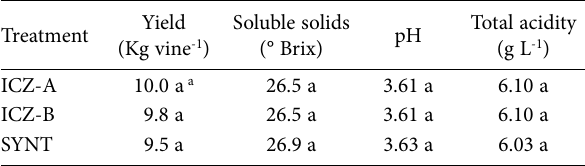
Table 9. Mean grape yields and grape composition parameters recorded in 2017 at harvest, for cv. Montepulciano vines in the CSA vineyard, treated with Italian chabasite-rich zeolitites (ICZ-A and ICZ-B) or synthetic products